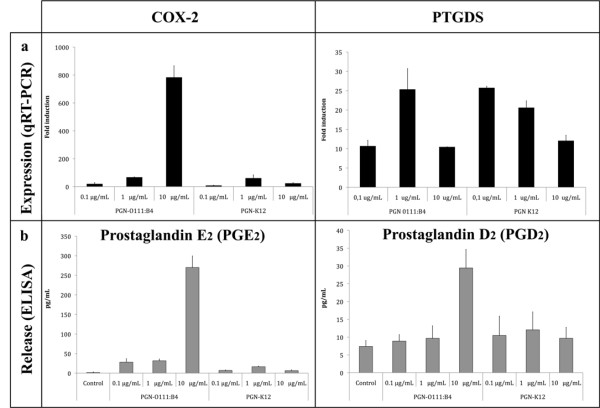
Concentration dependence of the prostaglandin response. Dose response (0.1, 1, and 10 μg/mL) of trout macrophages to PGN O111:B4 and K12 challenge. Experiments were performed overnight in independent macrophage cultures (n = 3). a) COX-2 and PTGDS mRNA abundance (black bar) in response to different doses of PGN-O111:B4 or PGN-K12 (0.1, 1, 10 μg/mL). Were observed significative differences in the mRNA abundance between different doses and treatments (PGNs) in both genes (two way ANOVAs p < 0.01). b) PGE2 and PGD2 release (pg/mL) into the culture medium (grey bars). Were observed significative differences in the release between doses and treatments (PGNs or control) by both prostaglandins (two way ANOVAs p < 0.01). The results are presented as fold change relative to 18S abundance and mean ± std deviation.